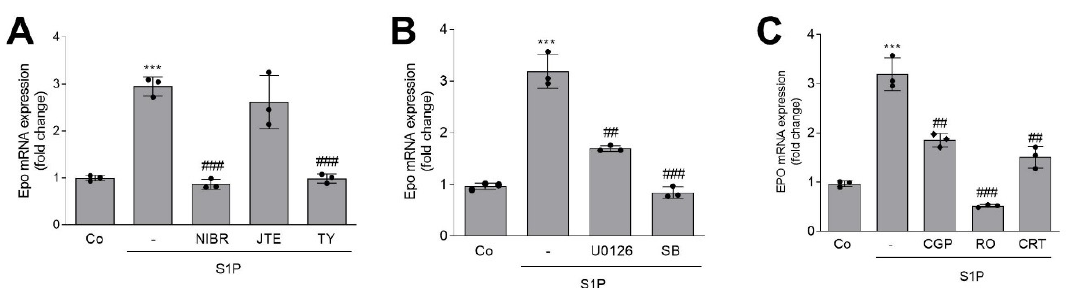
Figure 4. Effect of S1PR antagonists and specific inhibitors of ERK, p38-MAPK, PKC, and PKD on S1P-stimulated Epo mRNA expression in F3-5 cells. Confluent cells were incubated for 16 h in serum-free DMEM prior to stimulation for 6 h with S1P (500 nM) in the absence or presence of the following compounds: NIBR-0213 ( A , NIBR, 10 μ M), JTE-013 ( A , JTE, 10 μ M), TY52156 ( A , TY, 10 μ M), U0126 ( B , 10 μ M), SB203580 ( B , SB, 10 μ M), CGP41251 ( C , CGP, 100 nM), RO-318220 ( C , RO, 1 μ M), and CRT0066101 ( C , CRT, 1 μ M). RNA was extracted and taken for quantitative PCR analysis of mEpo and mL28 RNA. ΔΔ Ct values were calculated as a fold increase compared with the untreated control and means ± S.D. ( n = 3); *** p < 0.001 was considered statistically significant compared with the control samples; ## p < 0.01, ### p < 0.001 compared with the S1P-stimulated samples.